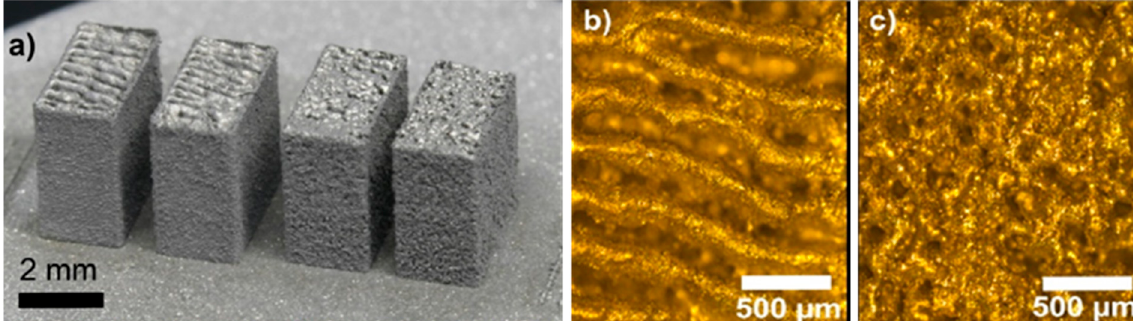
Figure 25. ( a , b ) Figures of a gear wheel fabricated at a scanning speed of 0.7 m/s, pulse energy of 1.5 µJ and 20 MHz pulse repetition rate; ( c , d ) light microscope images at different locations on the gear [60].